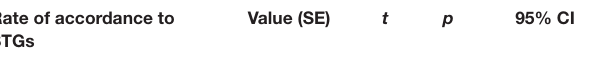
TABLE 3 | Estimates from interrupted time-series models of changes in STGs compliance rate for children and adult with three sample